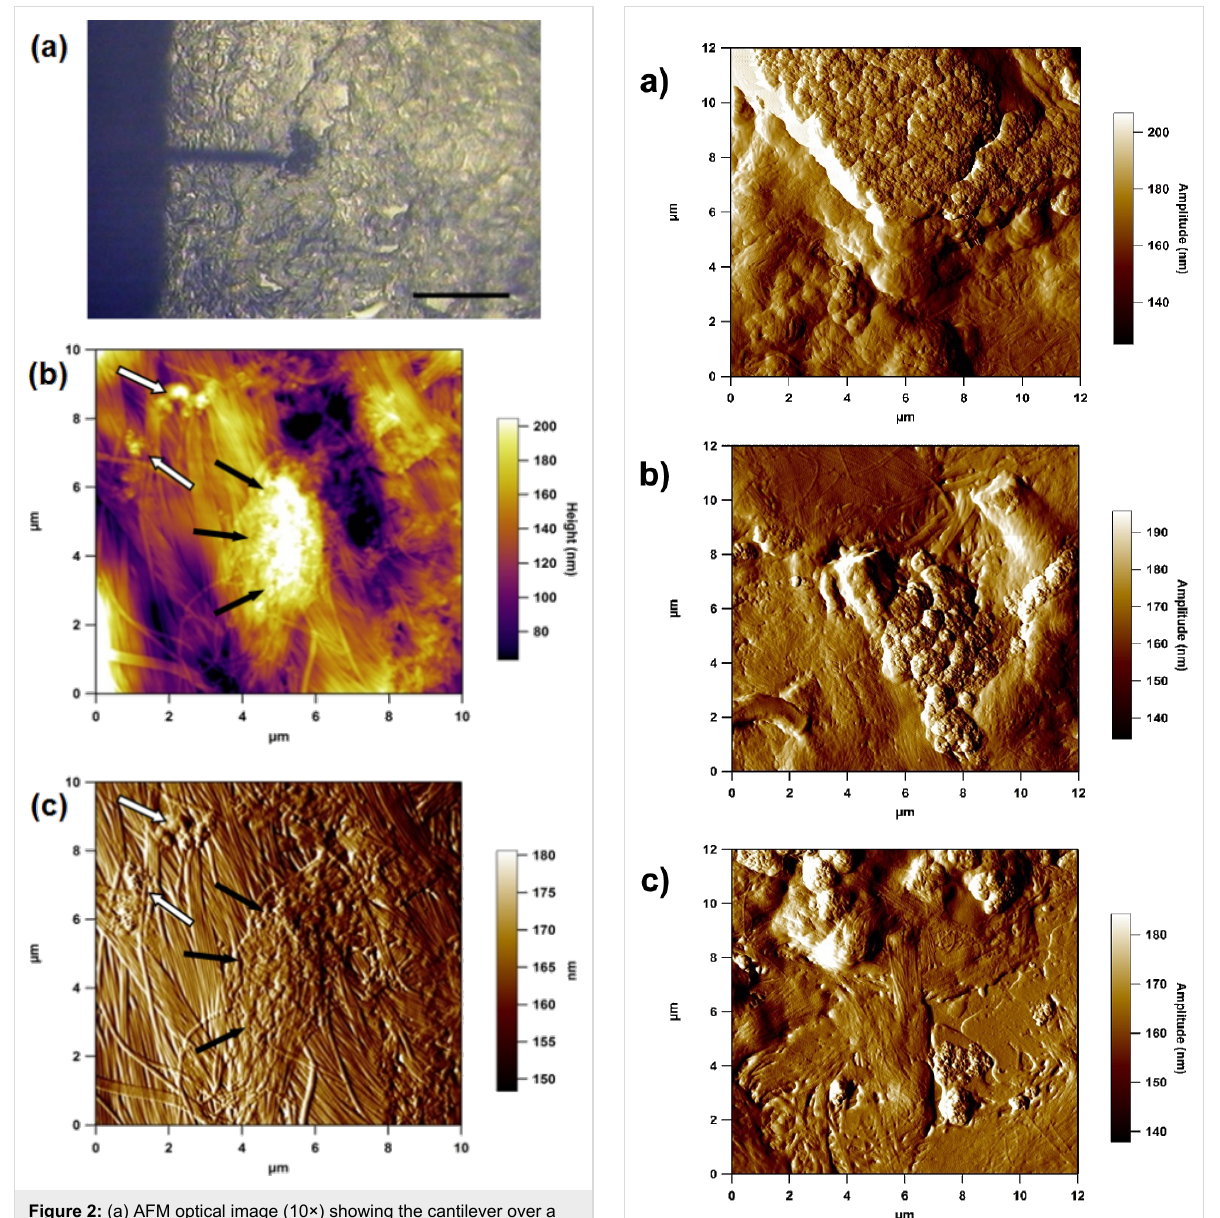
images (Figure 4b and Figure 4d), the periodic banding that